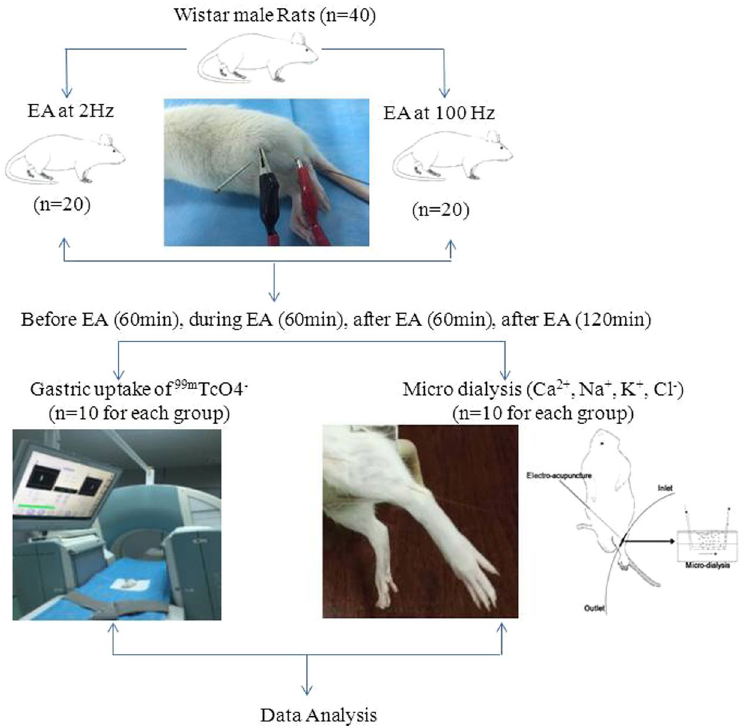
Figure 1. Flow chart of our